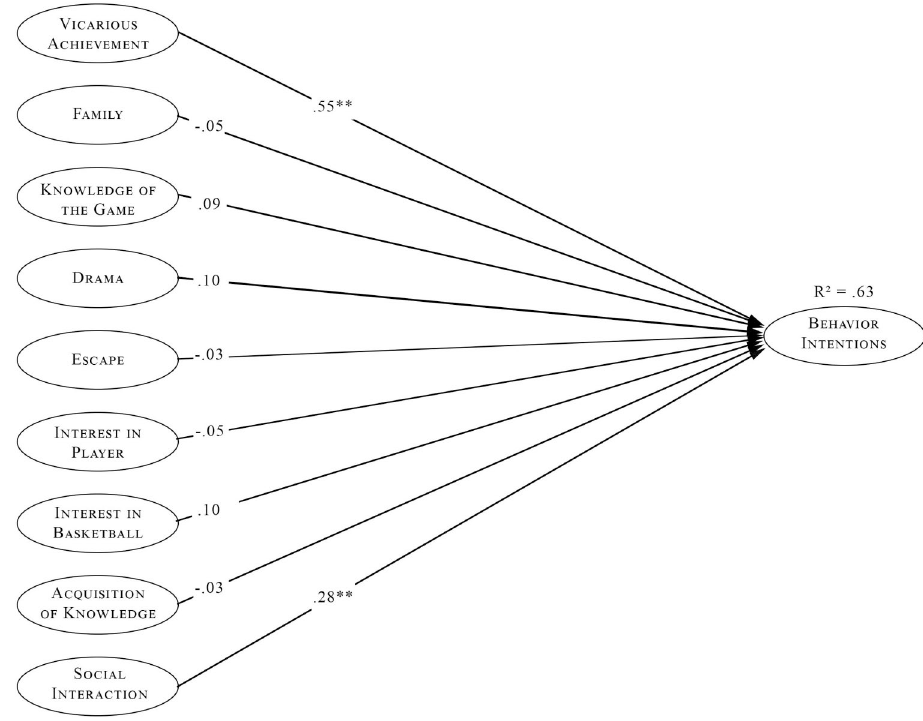
Figure 1 - Proposed causal model for the analysis of motives for consuming the NBA on behavioral intentions. Note: ** = p <